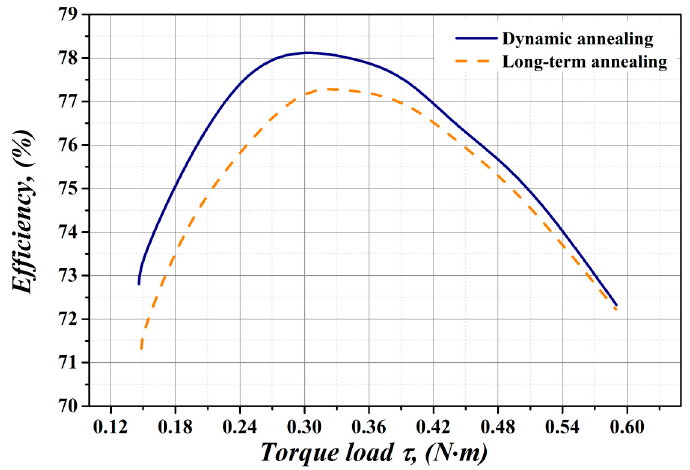
Figure 11. Efficiency dependence of electrical motors constructed from the segments heat treated in dynamic (solid blue line) and long-term (dashed orange line) conditions on the torque load.